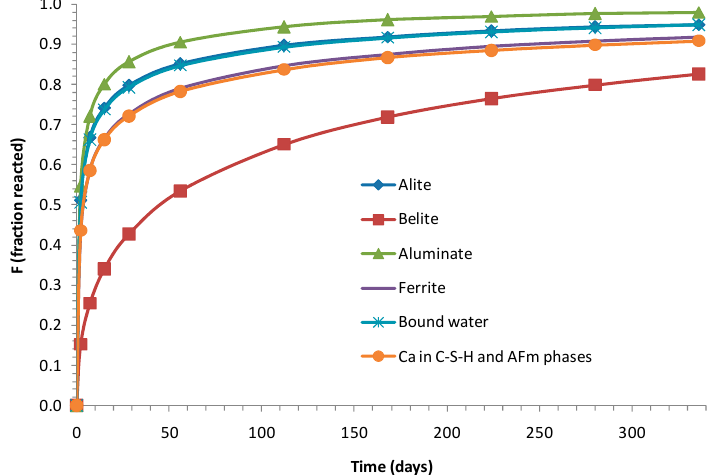
Figure 1. Fraction reacted for each clinker phase, C 3 S, C 2 S, C 3 A and C 4 AF, bound water, and Ca in the C-S-H and AF m phases over time, as calculated by using Equation (5).